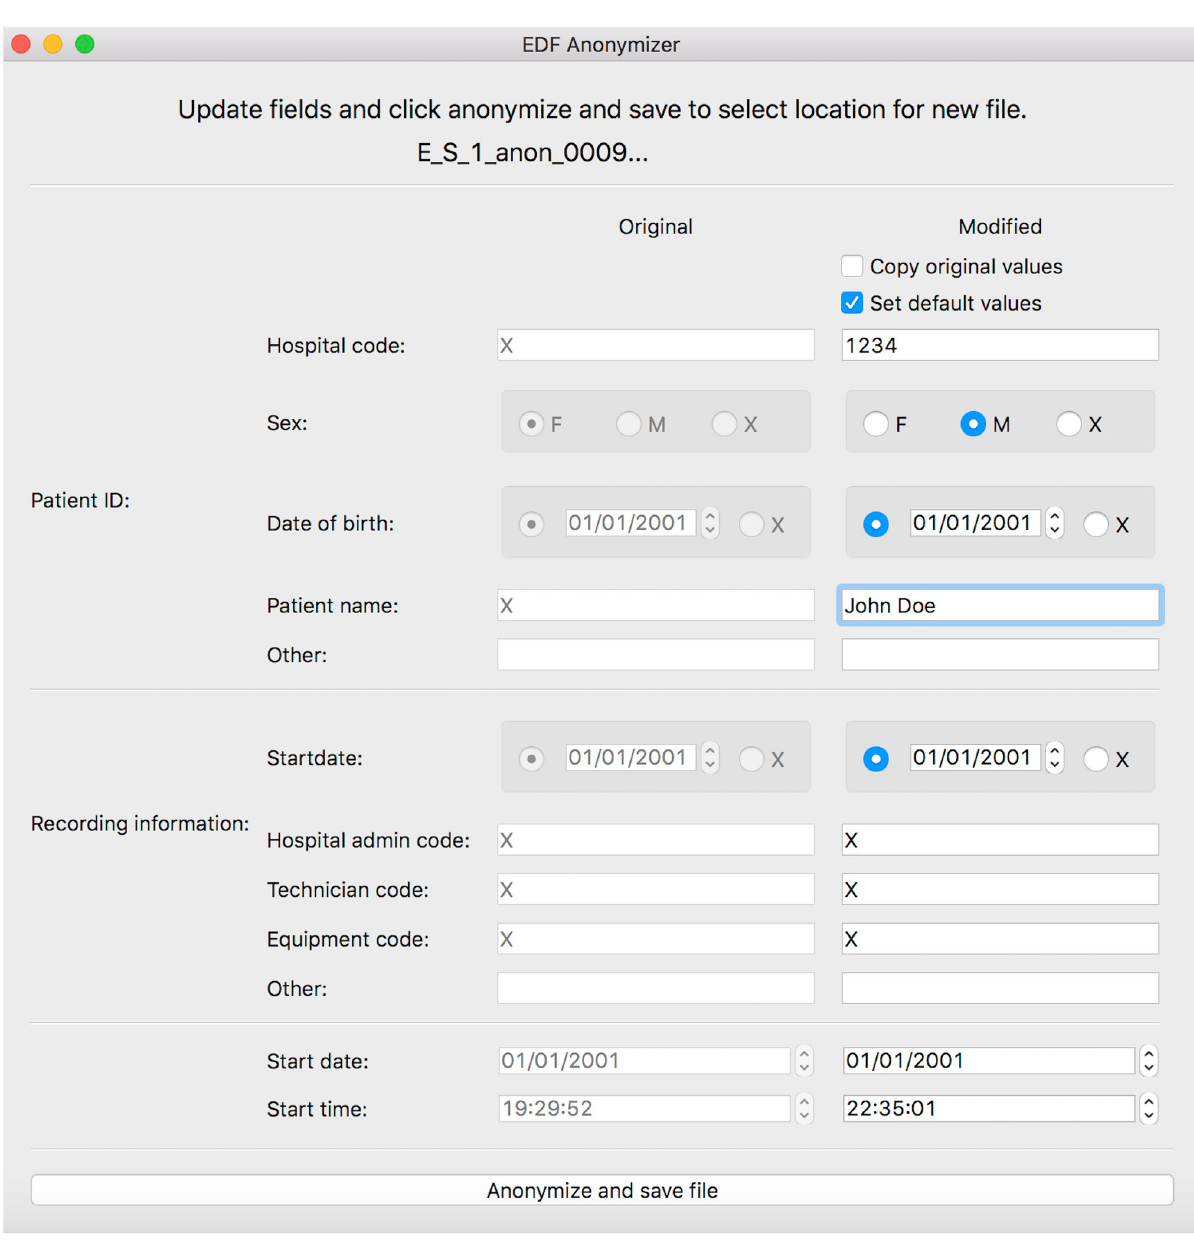
Fig 4. Anonymization window. This option can be used to strip identifiable information from the EDF file prior to